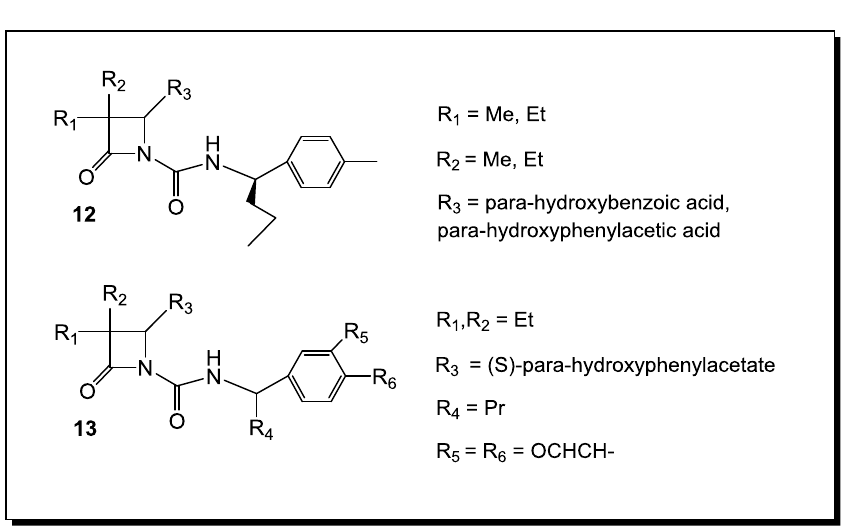
Figure 6. β-Lactams active against Escherichia coli leader peptidase.